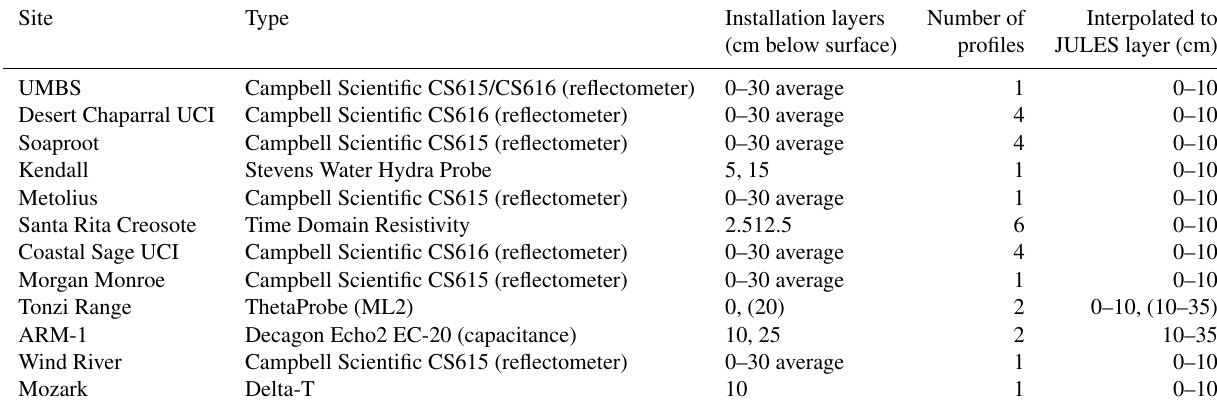
Table A2. Data used per site for downward longwave radiation ( L win ), net radiation ( R net ), and atmospheric pressure ( P atm ). A is AmeriFlux Level 2, COSMOS is the COSMOS website, and NLDAS is National Land Data Assimilation Systems Forcing data Phase 2 (http://disc.sci.gsfc.nasa.gov/uui/datasets?keywords= NLDAS).